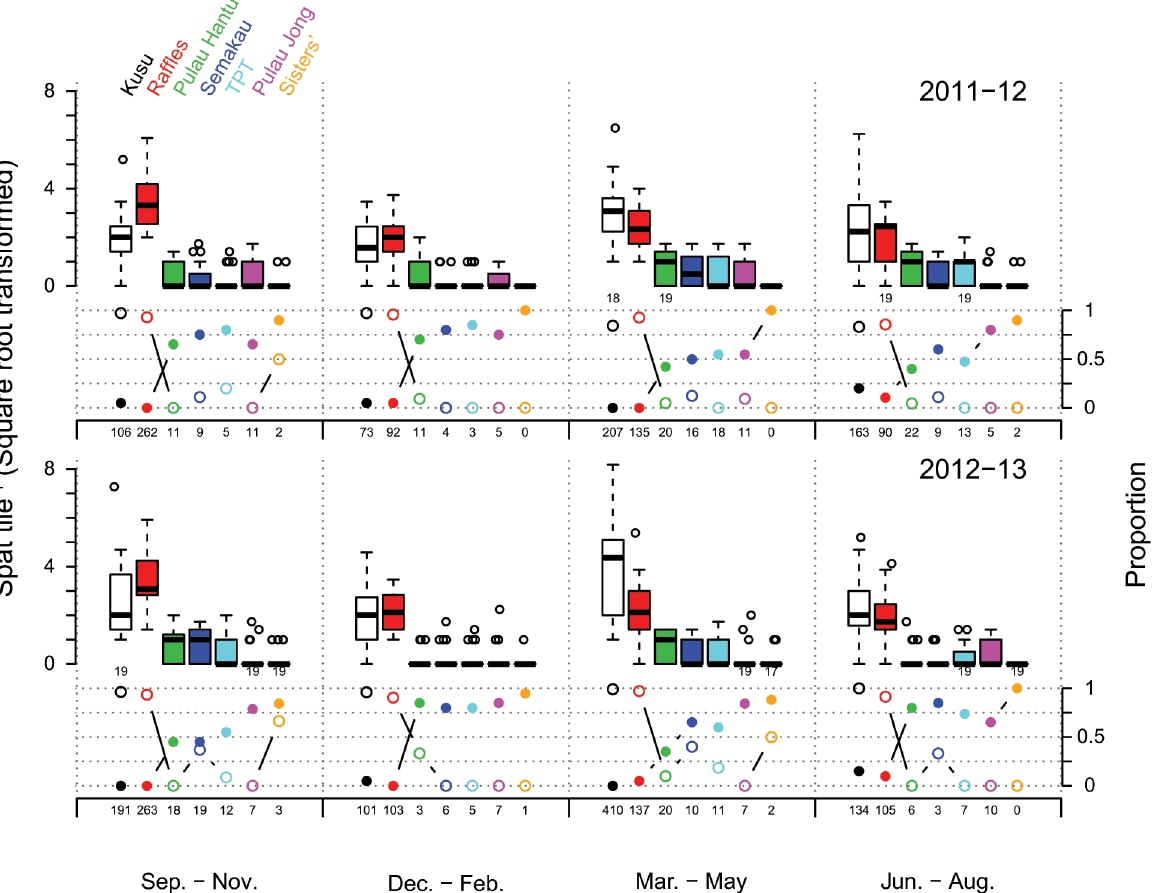
Fig 2. Boxplot of counts of total spat tile -1 (square root transformed) for each site (see legend, top left) and sampling period, for 2011 – 12 and 2012 – 13. Points above boxes represent outliers outside 1.5 × the interquartile range. Plots below boxplots show the proportion of tiles with zero spat (filled circles) and proportion of spat identified as Pocilloporidae (open circles). Twenty tiles per site, per sampling period were surveyed unless indicated under the x-axes of the boxplots. Numbers below the proportions x-axes are the total spat counts for each site and sampling period. Sites were ordered from left to right according to descending rank abundance of total spat over the entire study